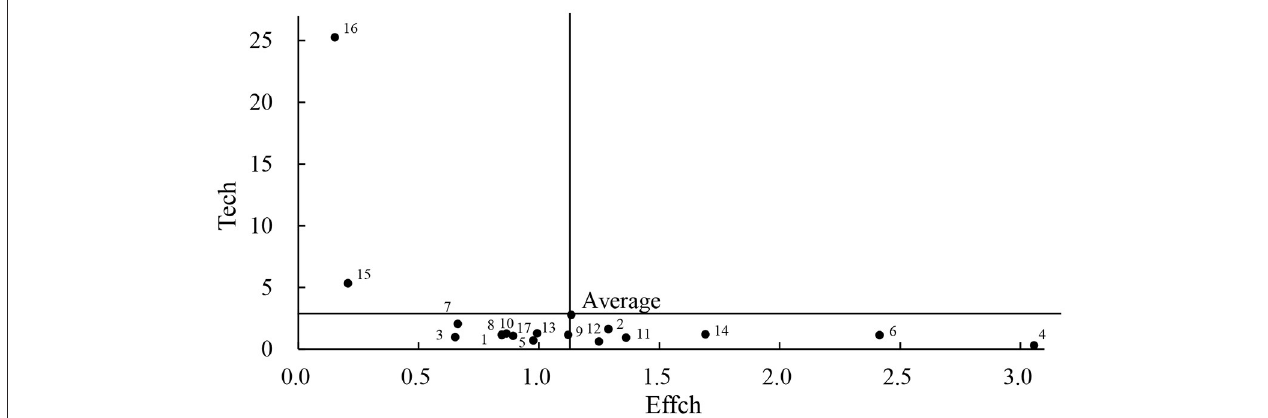
FIGURE 3 | Composition of changes in comprehensive efficiency of the 17 sample enterprises in 2020.